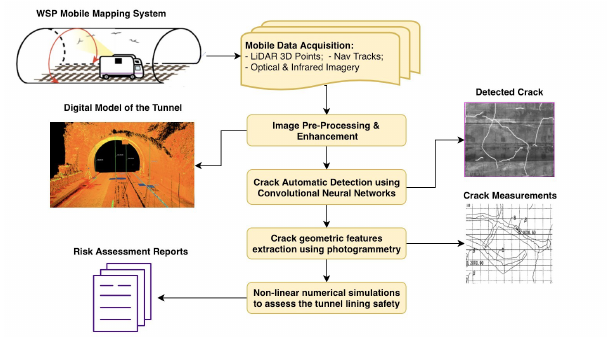
Figure 1. Methodology overview